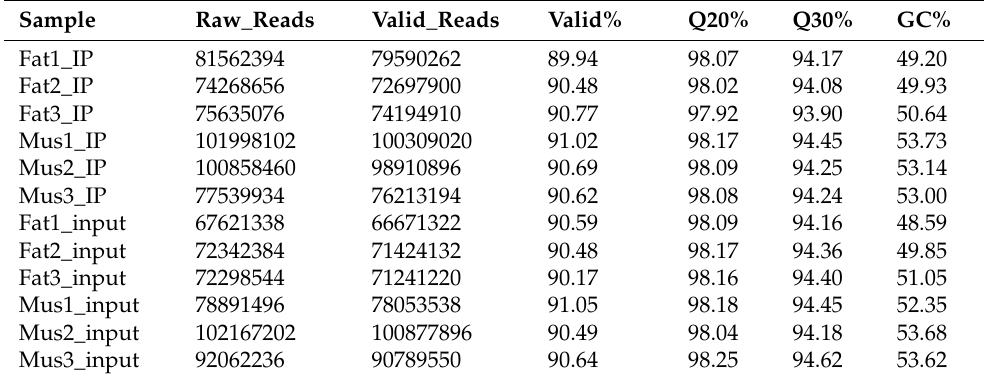
Table 2. Summary of reads quality